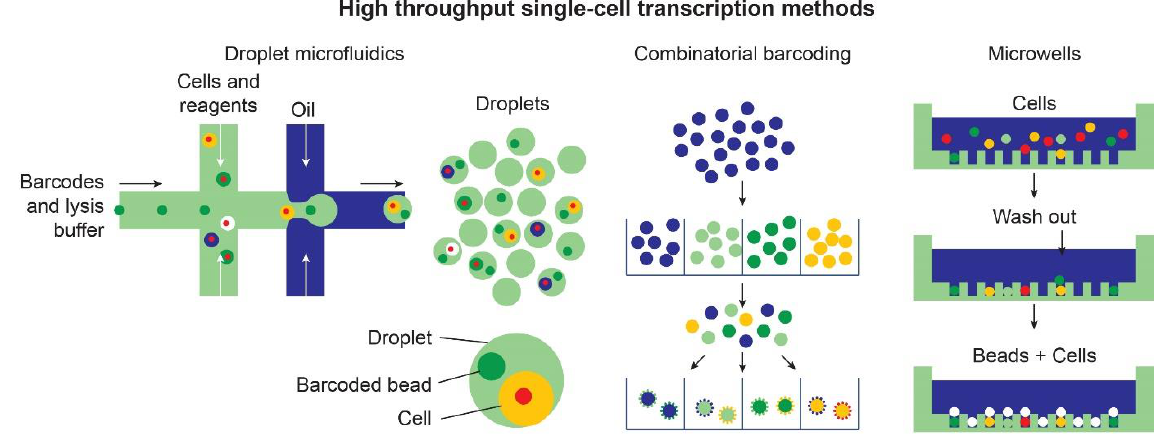
Figure 3. Single-cell RNA sequencing approaches to investigate cell heterogeneity in human organoids.